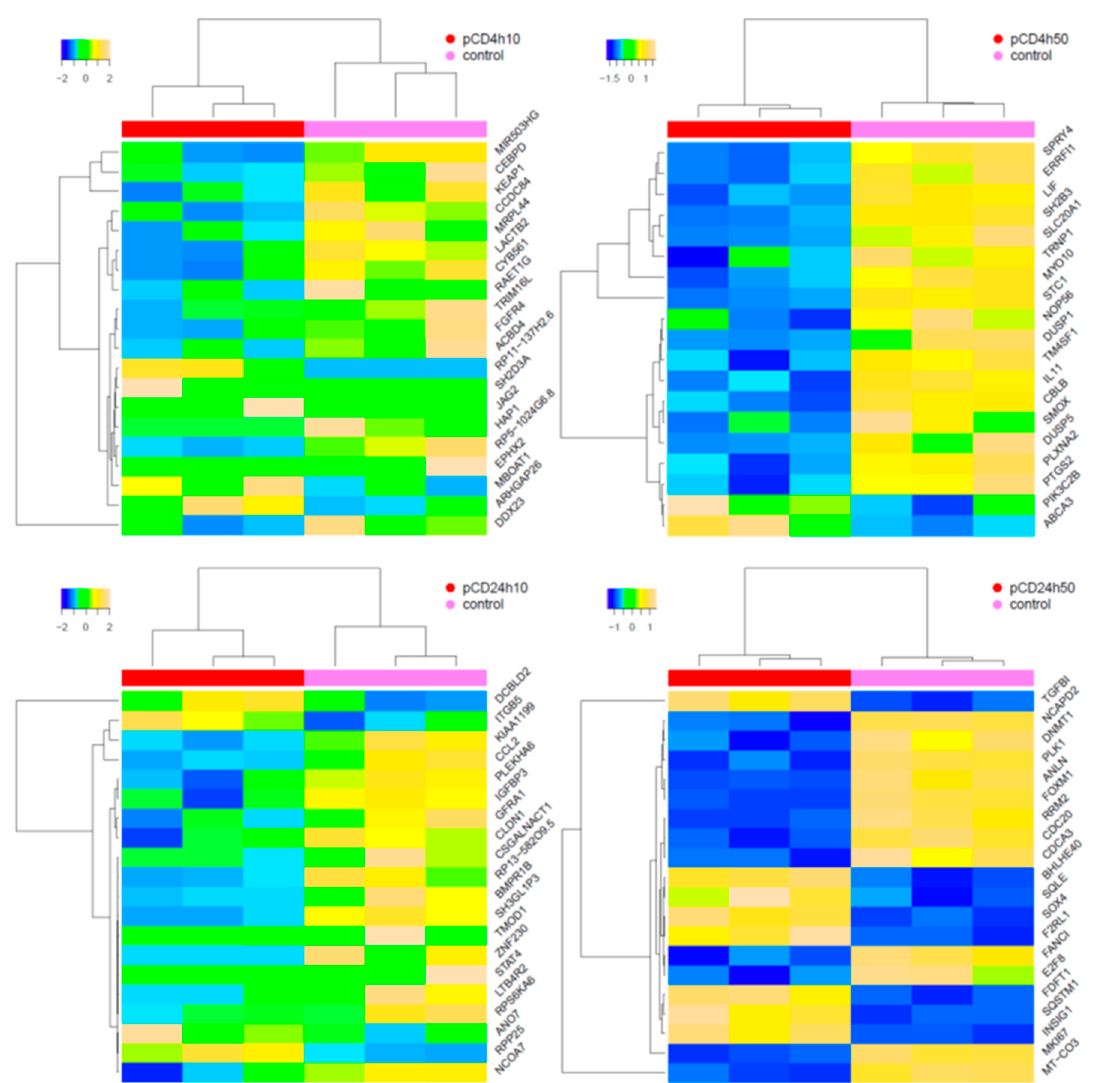
Figure 4. Hierarchical clustering of top-ranked differentially expressed mRNAs in samples exposed to pCD when compared with the controls. The 20 most significantly deregulated transcripts are shown.